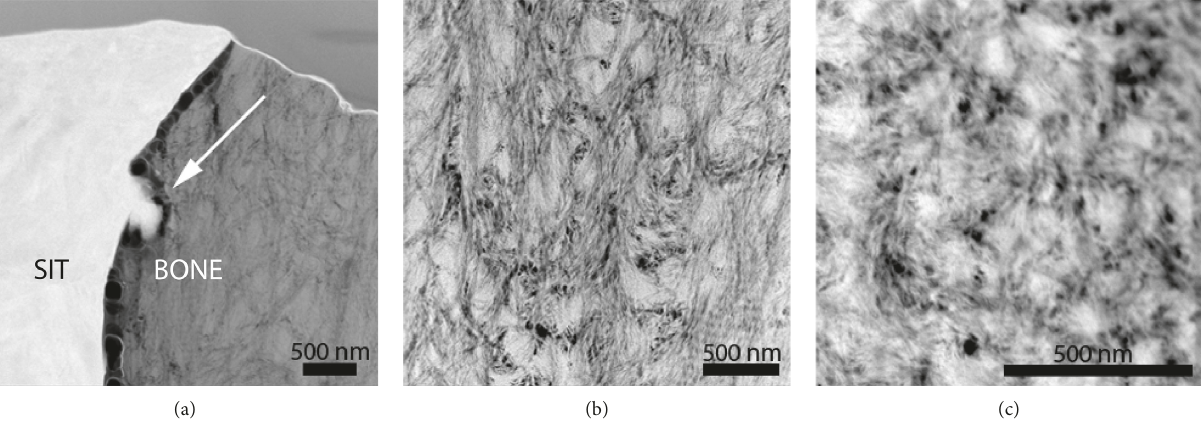
Figure 9: HAADF STEM images of (a) the SIT implant-bone interface after 12-week implantation. Bone growth around the nanoscale features was observed (arrow). (b) Ordered collagen fibrils, representative of mature bone, are noted adjacent to the implant at 12 weeks, while at 3-week implantation (c) partially disorganized collagen fibrils, representative of newly developing woven bone, are noted adjacent to the implant, consistent with the new bone